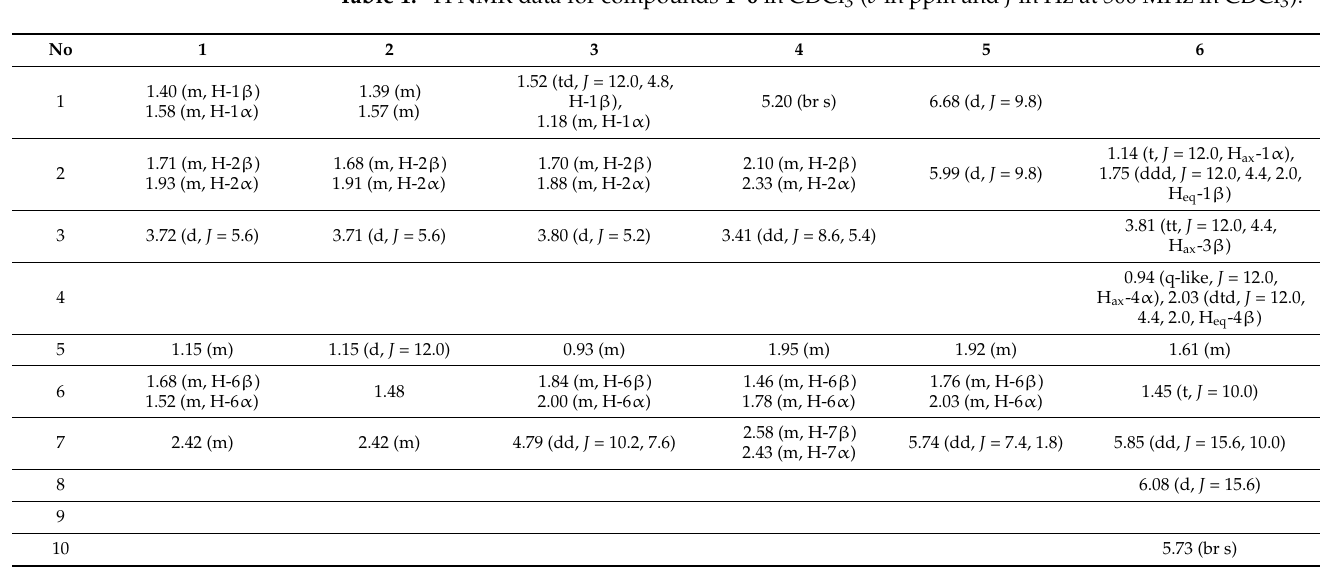
Figure 2. Key COSY ( ▬ ) and HMBC ( → ) correlations of 1 ‒ 6 . Table 1. 1 H NMR data for compounds 1 – 6 in CDCl 3 ( δ in ppm and J in Hz at 500 MHz in CDCl 3